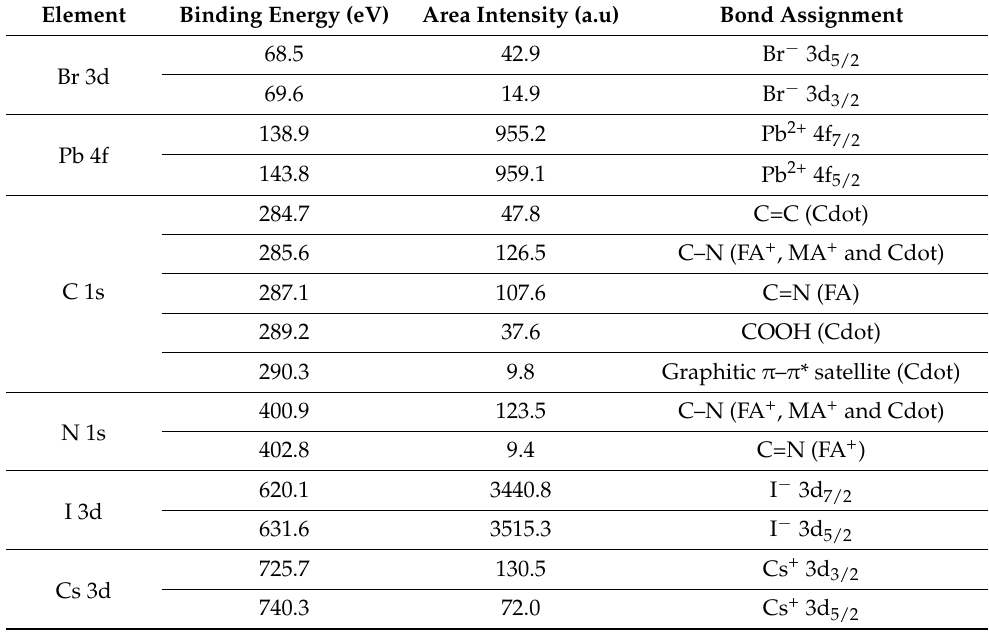
Table 1. The XPS binding energies and area intensities of elements in Cdot-embedded perovskite solar cells. Element Binding Energy (eV) Area Intensity